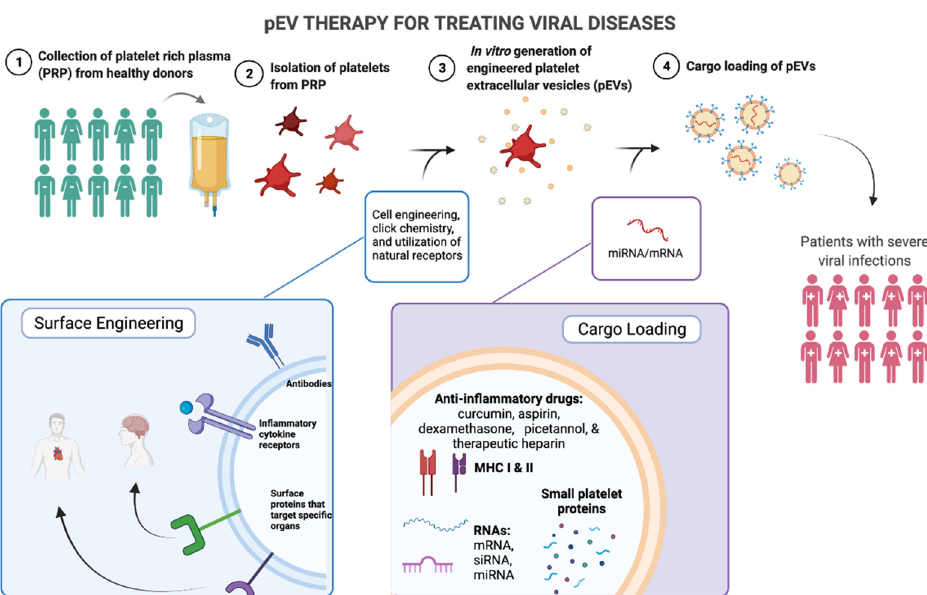
Figure 5. Platelet Extracellular Vesicle (pEV) Therapy for Treating Viral Diseases. 1. Platelet rich plasma (PRP) is isolated from healthy donors. 2. Platelets are isolated from PRP. 3. Surface engi- neering of platelets could involve the incorporation of receptors aimed at carrying out specific functions to treat a disease. In vitro culture methods are used to generate pEVs. 4. pEV cargo load- ing involves small drugs, molecules, and RNA. EV surface targeting includes antibodies, inflam- matory cytokine receptors, and proteins that specifically target certain organs. After cargo loading, pEVs would be isolated to a clinical grade-level and administered to treat patients with severe viral infections. Created with BioRender.com (9 February